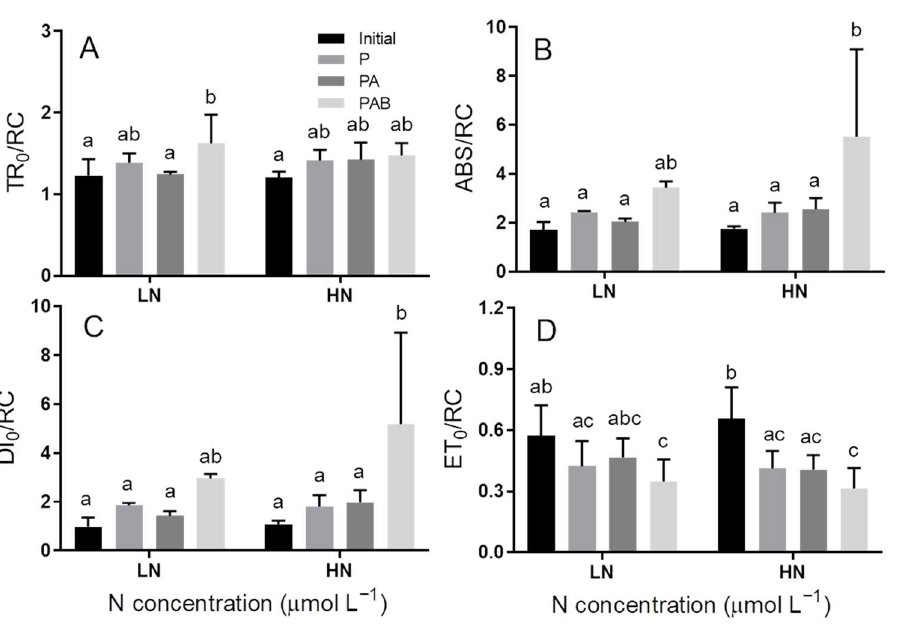
Figure 7. TR 0 /RC ( A ), ABS/RC ( B ), DI 0 /RC ( C ), and ET 0 /RC ( D ) of Sargassum horneri under P, PA, and PAB treatments. Significant differences among all treatments are indicated by different lowercase letters ( p < 0.05).